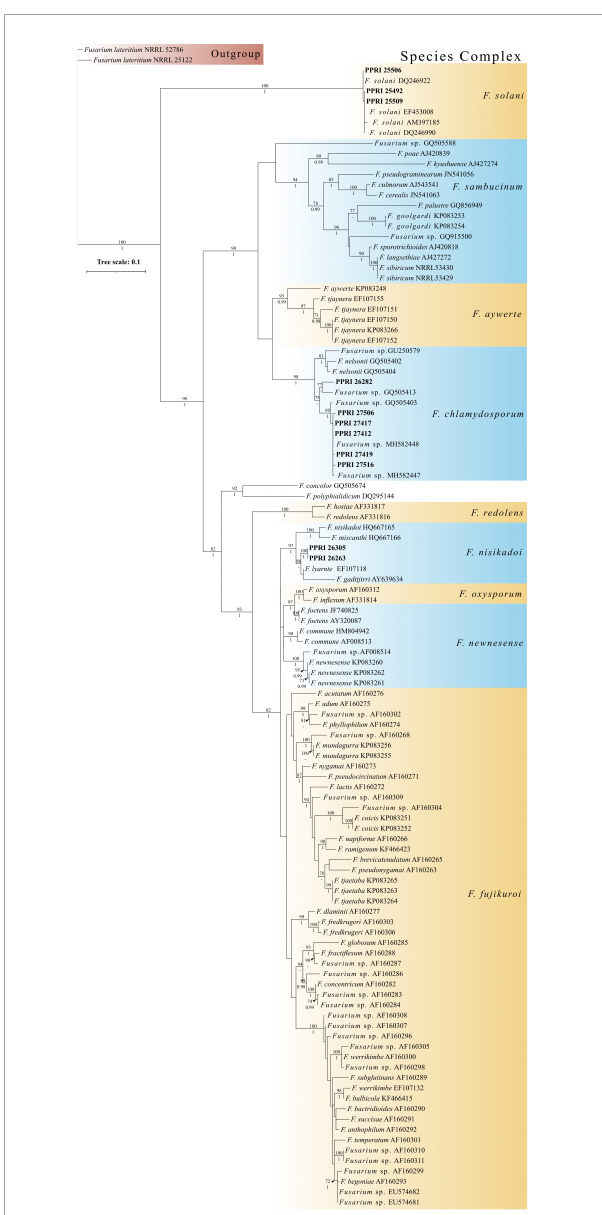
FIGURE9 Phylogenetic tree of the minor species complex dataset inferred from the tef-1 α gene region for 113 taxa. Isolates from the GGHNP are indicated by PPRI number and are marked in bold. Branch support values are indicated as ML-BS/PP values ( > 0.98/ > 70%) above the branches at the corresponding